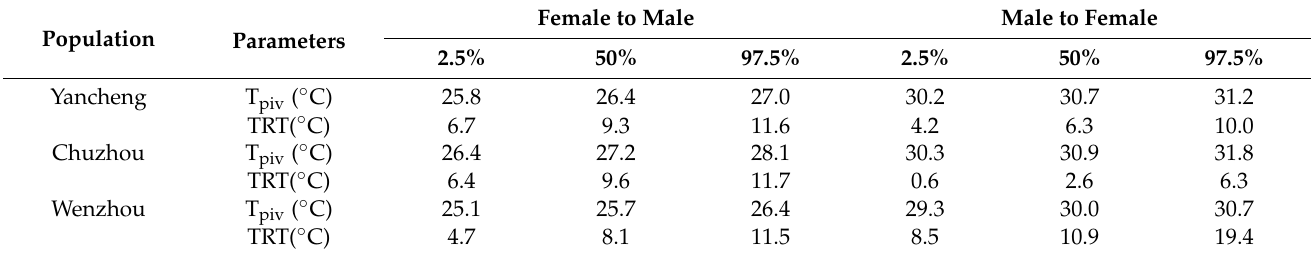
Table 3. Quantiles (2.5%, 50%, and 97.5%) for pivotal temperature (T piv ) and transitional range of temperatures (TRT) for Gekko japonicus from different populations using Bayesian MCMC with a logistic